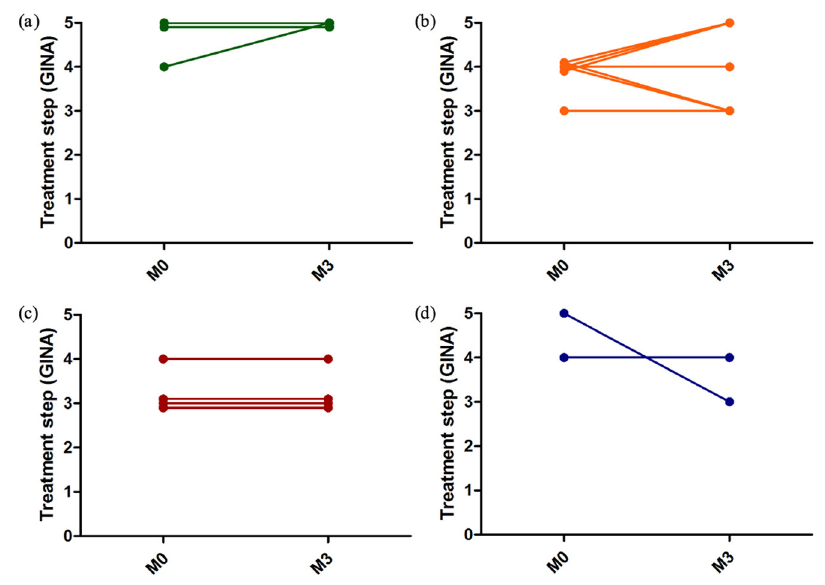
Figure 8. Treatment steps according to GINA (Global Initiative for Asthma) at the beginning (M0) and at the end (M3) of the study according to the perception profile. Each line represents one patient. ( a ) good perceivers; ( b ) anarchic perceivers; ( c ) poor perceivers; ( d ) excessive perceivers.